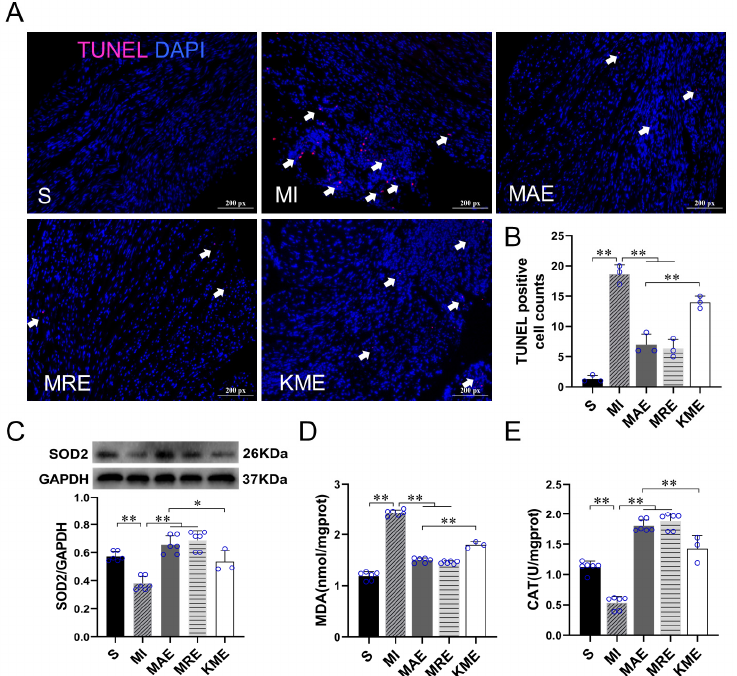
Figure 6. Exercise inhibited cell apoptosis and oxidative stress in the infarcted heart via FGF21. ( A ) TUNEL staining; the positive apoptotic particles showed red fluorescence, the nuclei showed blue, scale bar = 200 px; ( B ) statistical analysis of TUNEL staining; ( C ) the protein expression of SOD2; ( D , E ) MDA content and CAT activity. Data are expressed as mean ± Standard Deviation (SD), n = 8 in S, MI, MAE and MRE groups and n = 4 in KME group. Statistical method: one-way analysis of variance (ANOVA). * p < 0.05 and ** p < 0.01. S, Sham group; MI, MI-sedentary group; MAE, post-MI aerobic exercise training group; MRE, post-MI resistance exercise training group; and KME, the Fgf21 KO mice with aerobic exercise training